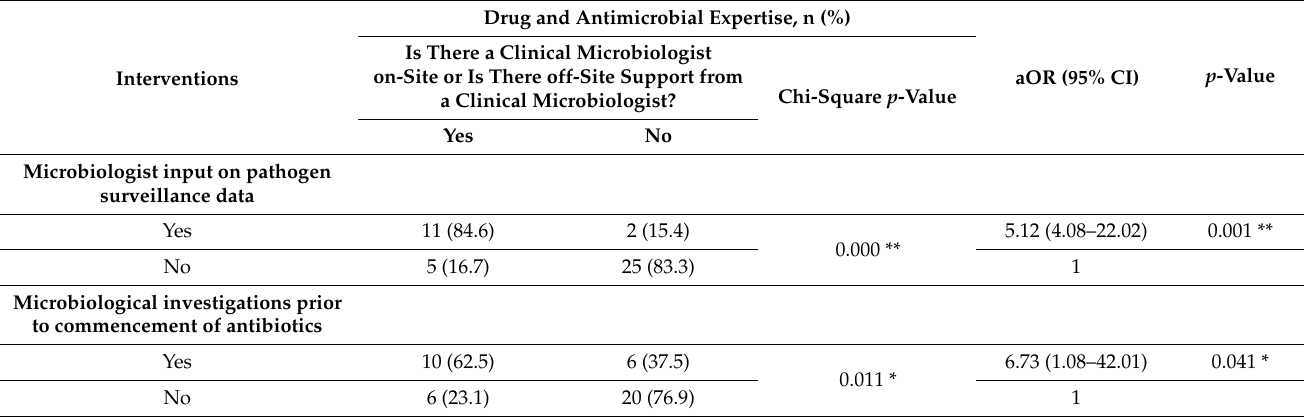
Table 2. Bivariate Chi-squared test of association and multivariable logistic regression: associations between drug and antimicrobial expertise (clinical microbiologist) and different AMS interventions.